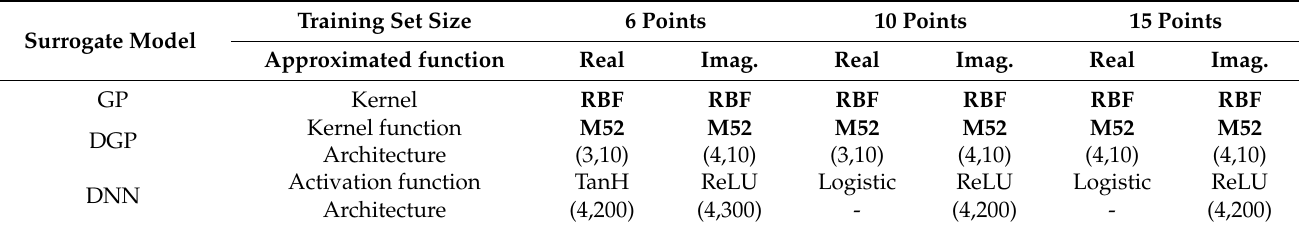
Table 12. Worst hyperparameter setting of GP, DGP and